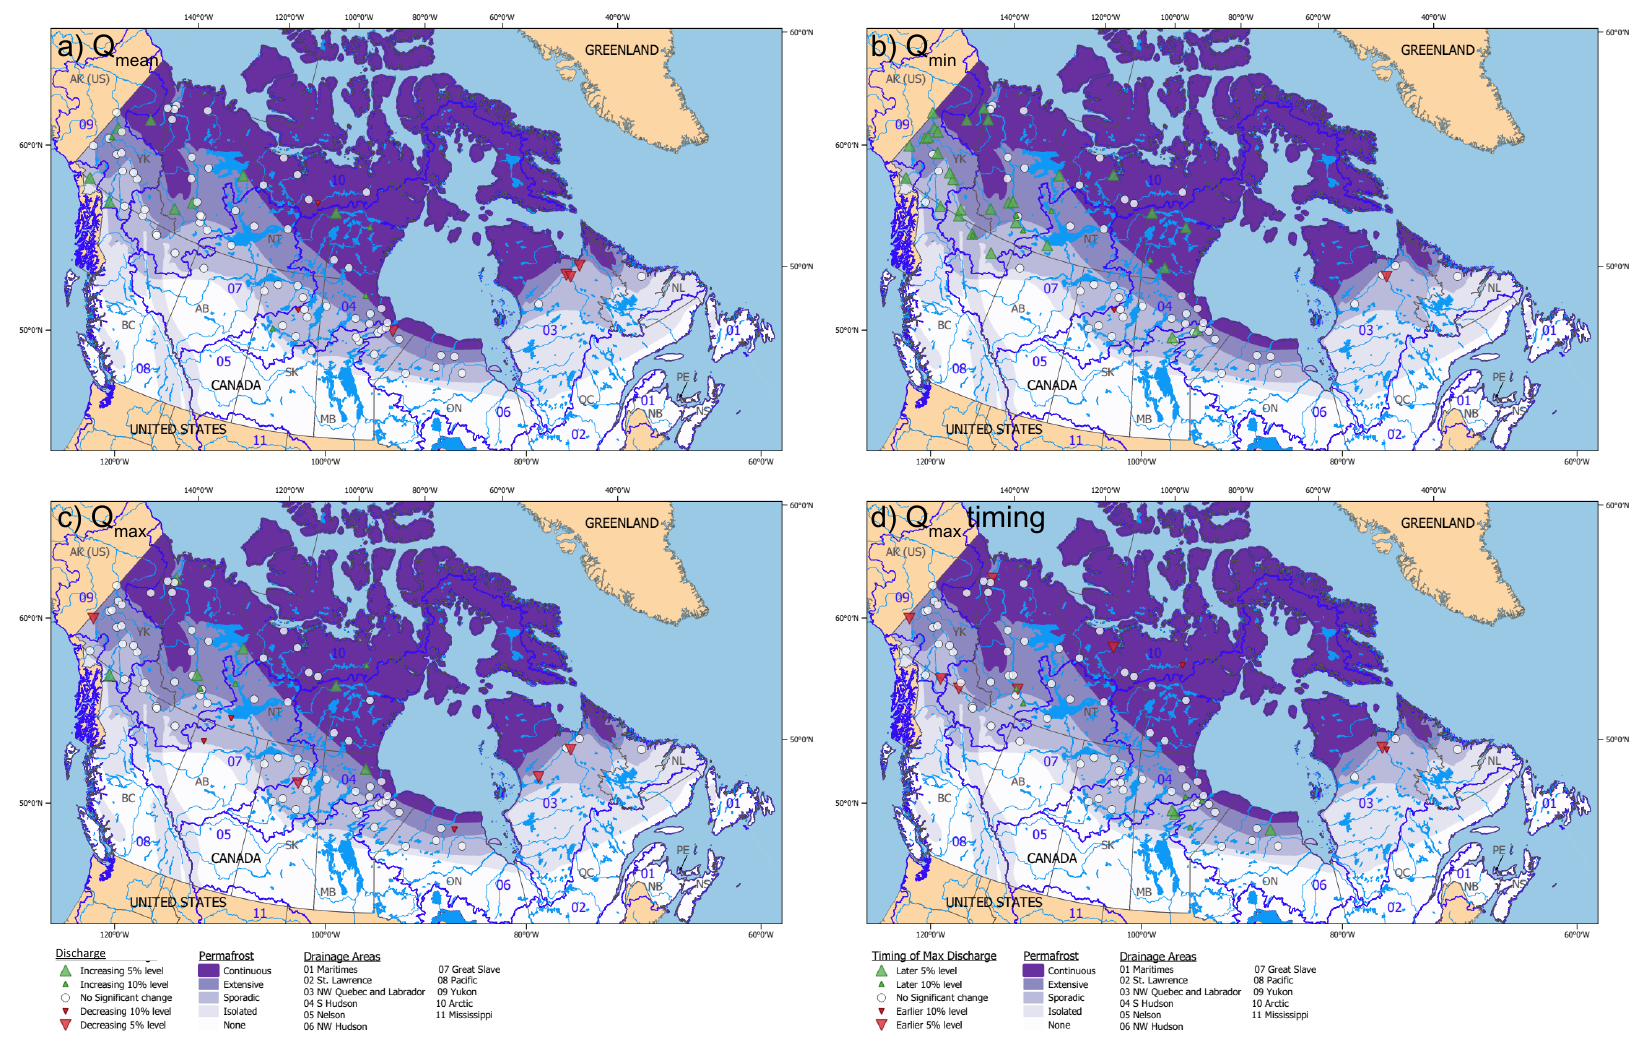
Figure 1. Historical trends in streamflow variables for the permafrost region of Canada: ( a ) Mean flow (Q mean ); ( b ) Minimum flow (Q min ); ( c ) maximum flow (Q max ) and ( d ) Q max timing. Significant increasing and decreasing trends at 5% and 10% levels are